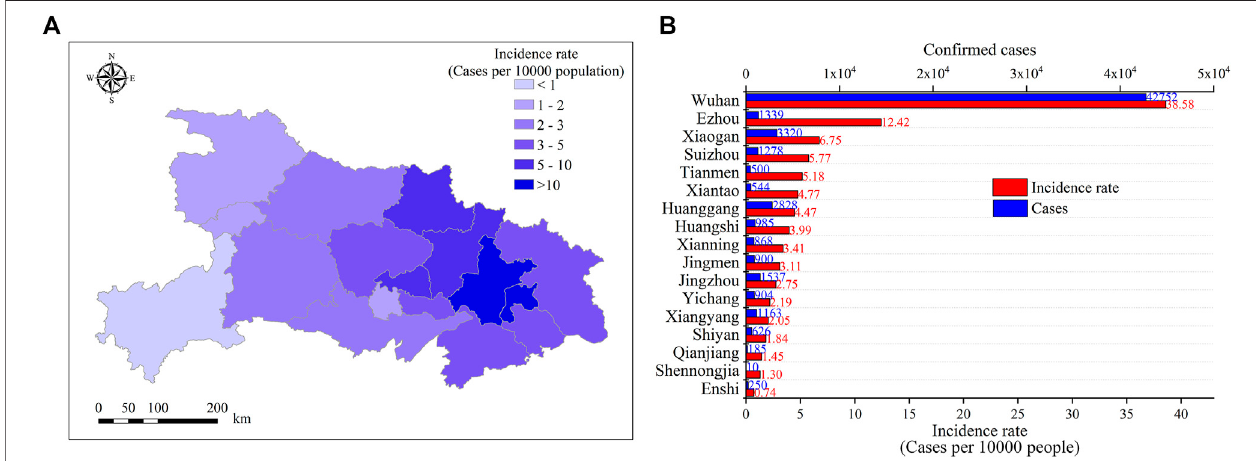
FIGURE 4 | Spatial distribution of the COVID-19 incidence rate in Hubei. (A) spatial distribution; (B) the amount of COVID-19 con fi rmed cases and their incidence rate.